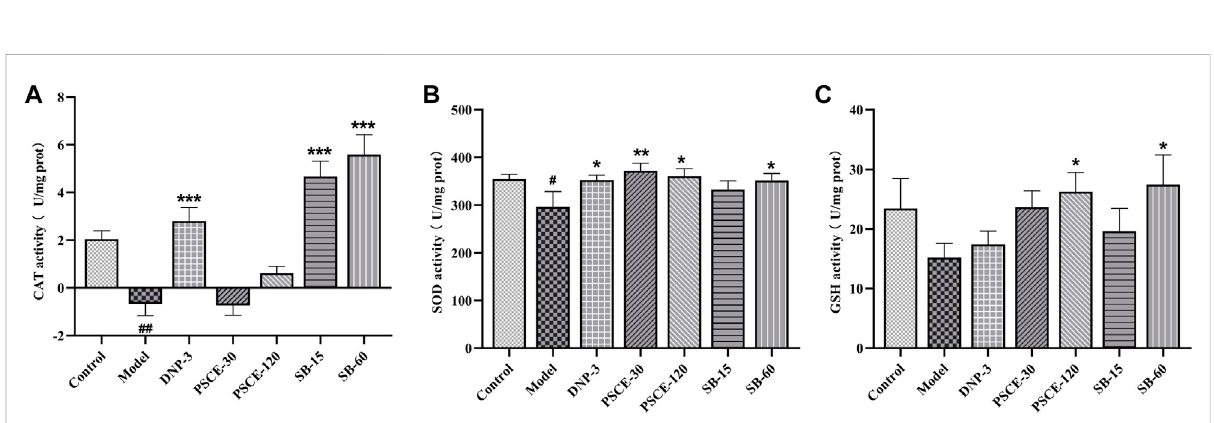
FIGURE 10 Effects of PSCE and SB on scopolamine-induced oxidative stress state. (A) CAT level in brain. (B) SOD level in brain. (C) GSH level in brain. Experimental values were expressed by mean ± SEM (n = 10 per group). Compared with the control group, # p < 0.05; Compared with model group,